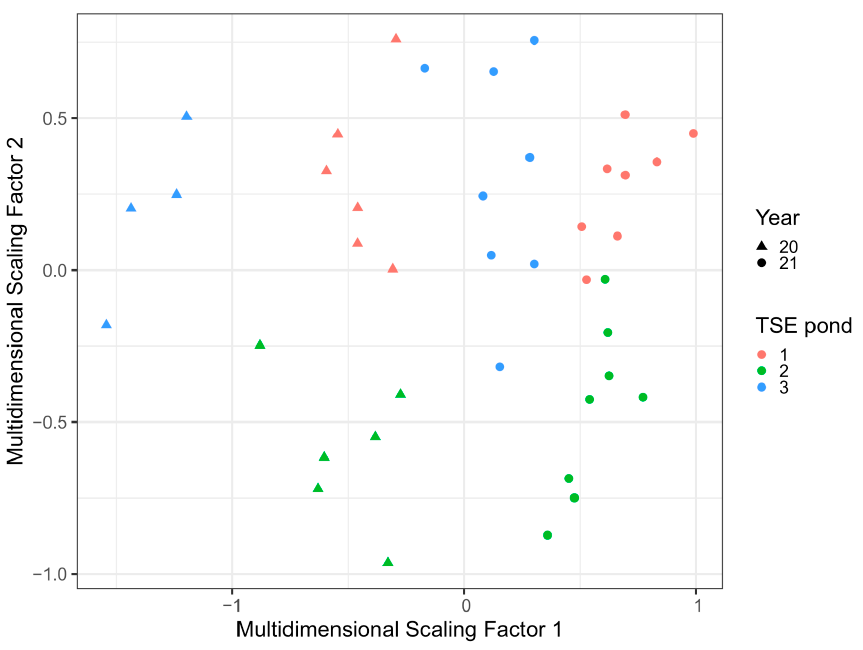
Figure 10. Changes in the composition of the bird community in September between 2020 and 2021